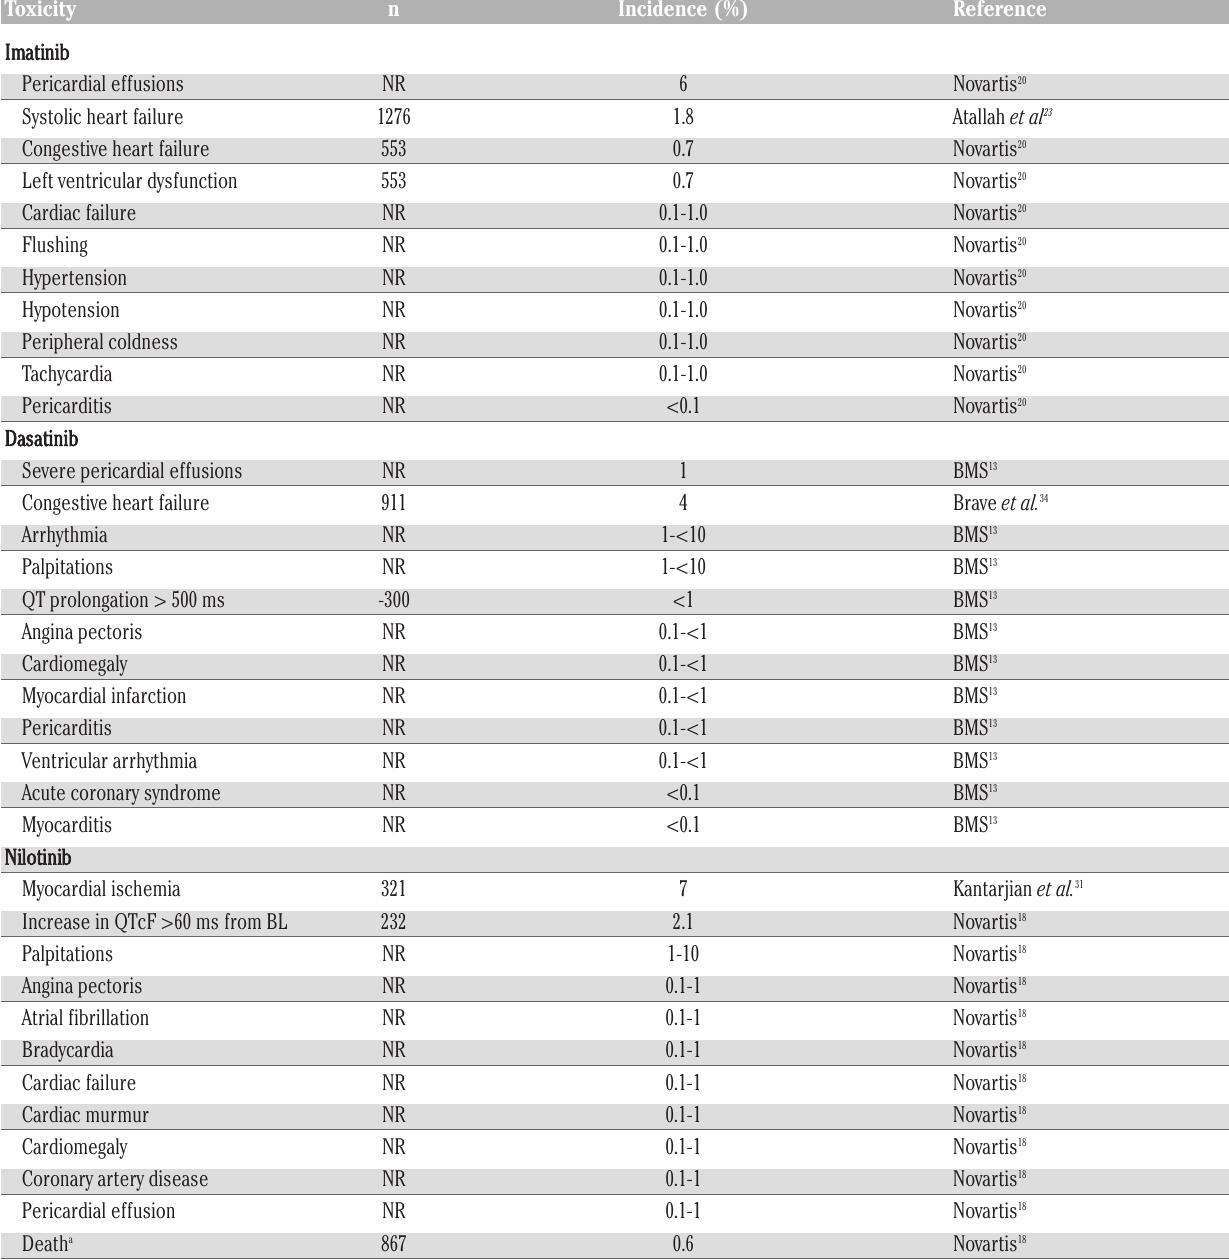
Table 1. Reported incidence of cardiotoxicity during tyrosine kinase inhibitors